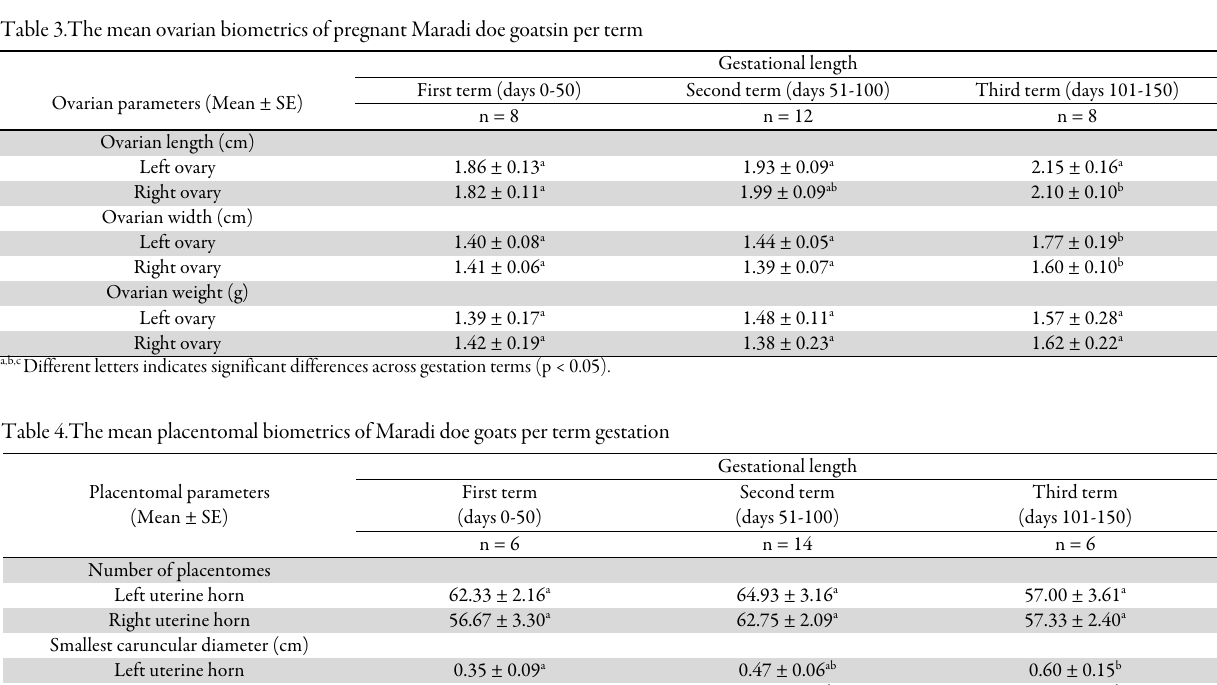
Table 3.The mean ovarian biometrics of pregnant Maradi doe goatsin per term